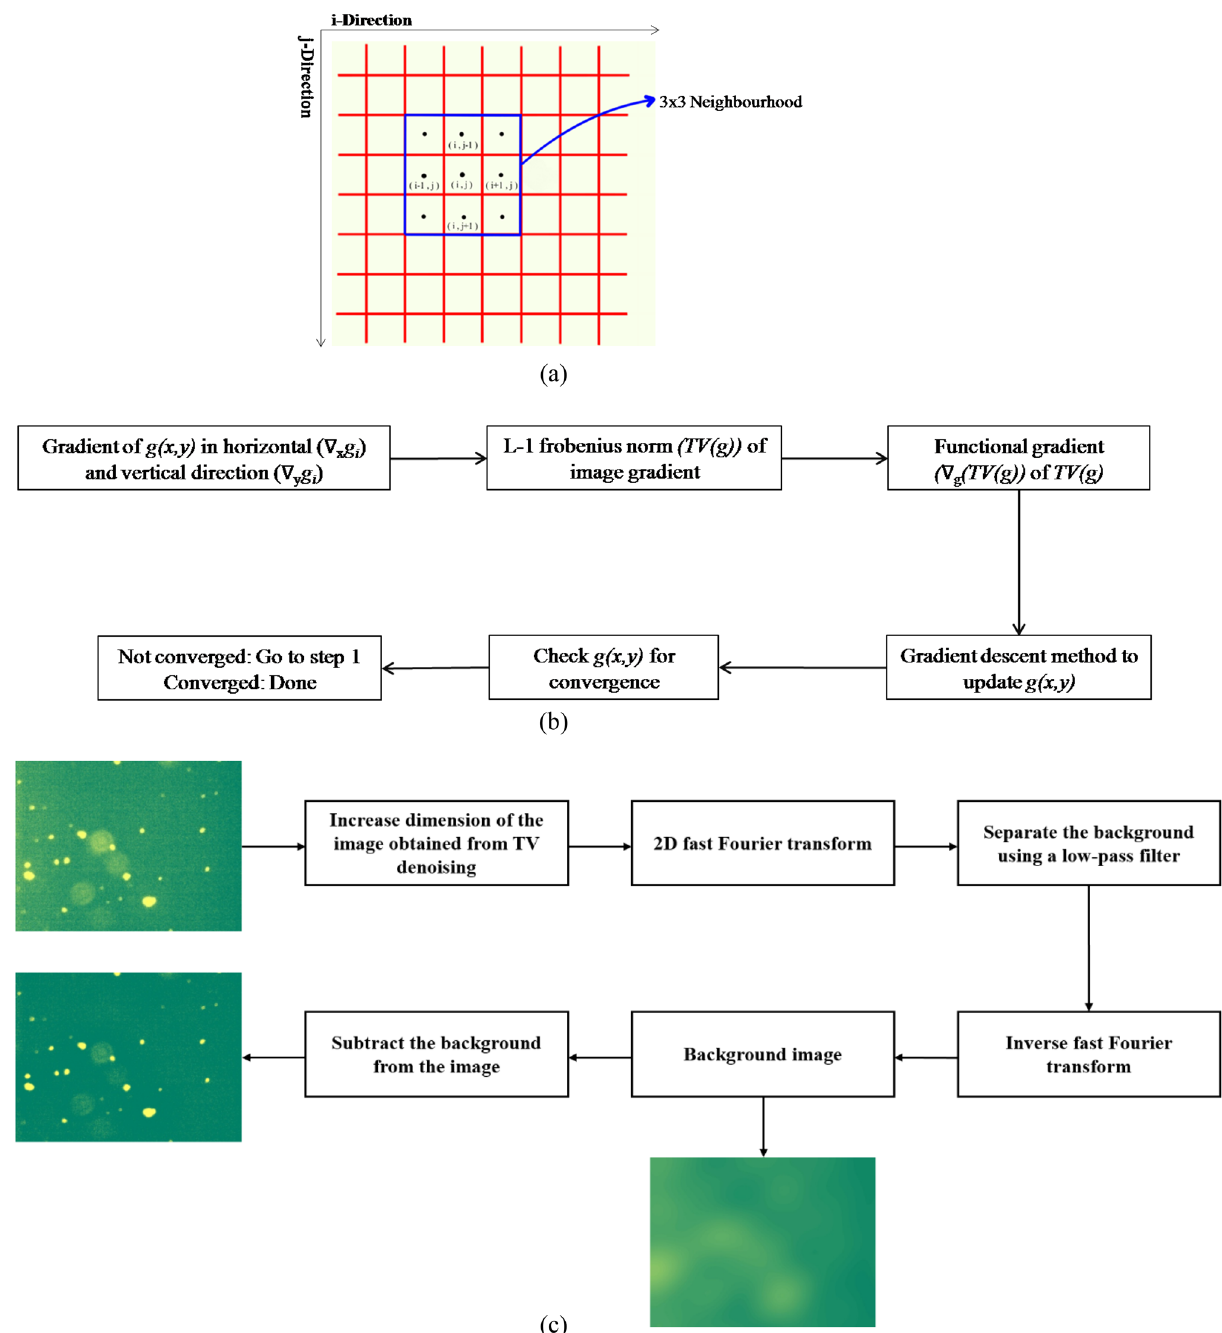
Figure 2. Various operations involved in de-noising steps where ( a ) is the median filtering, ( b ) is the steps involved in TV algorithm and ( c ) summarizes the process of background image obtained after this operation has normalized background which helps in uniform thresholding on the image. The steps for normalizing background are shown in Fig. 2c. Thresholding. Final step in image treatment after all the necessary steps of noise reduction is converting it into black and white (binary) image using thresholding method. Level of threshold ( T ) is calculated from differ- ent methods available or is user defined. T is compared with the modified image and the pixel values larger than T are assigned 1 corresponding to a white pixel. Pixel values less than threshold are marked 0 which corresponds to black pixel as shown in Eq. (5). The different modes of thresholding used are shown in Fig. 3a–c.